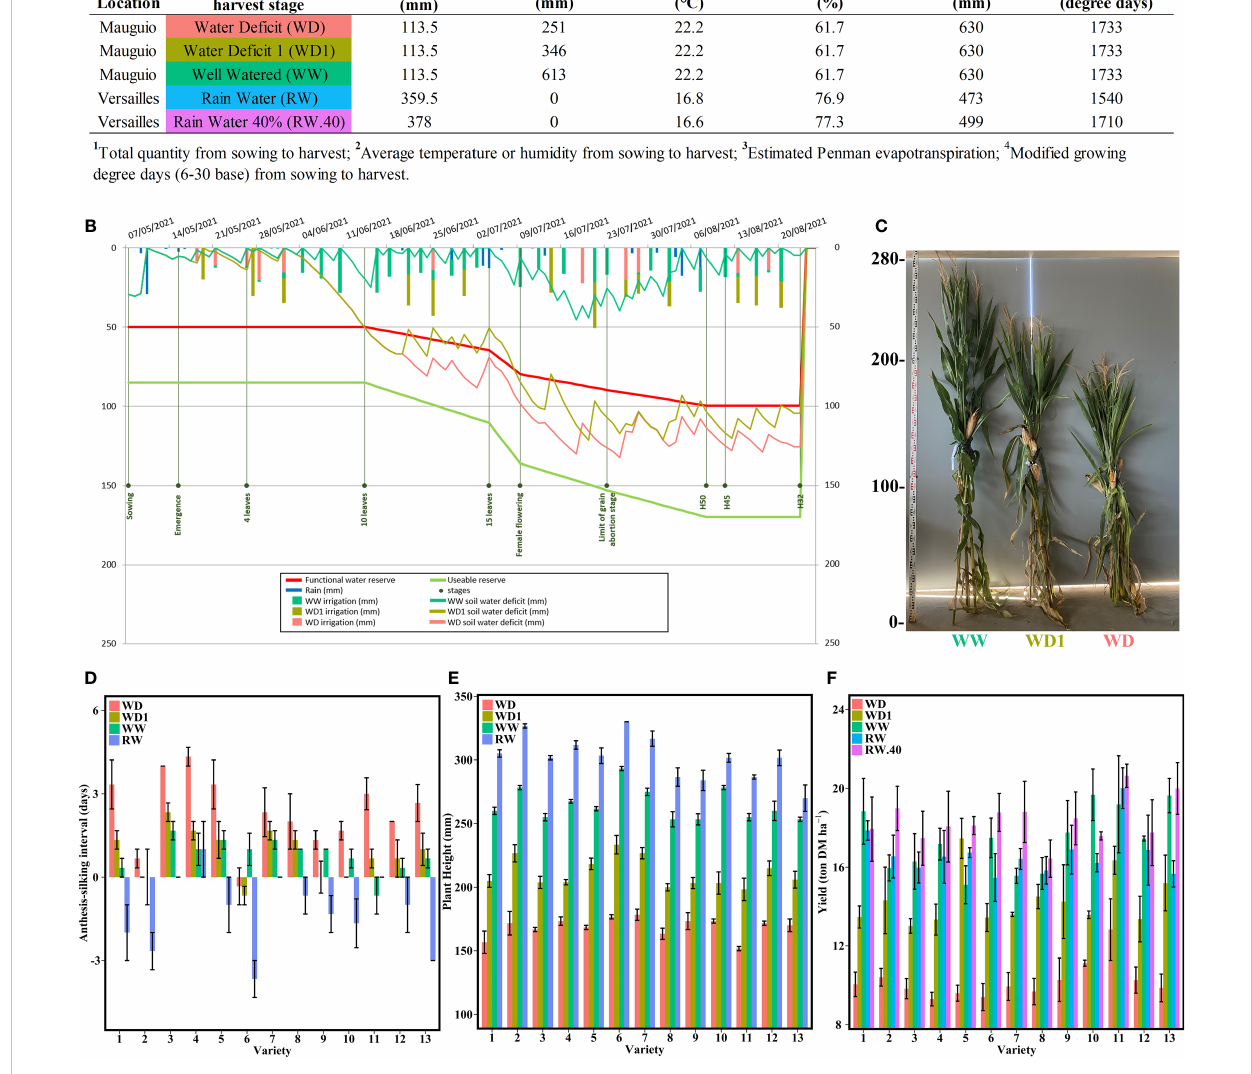
FIGURE 1 Harvest conditions and resulting effects on key agronomic parameters. (A) Main climatic and maintenance data related to the fi ve different conditions studied. (B) Water balance sheet generated by the Irre ́ lis irrigation advice software (Arvalis – Institut du vegetal) for the Mauguio fi eld trials. The data shown were measured on variety 8 in the WW condition. (C) Representative photo of the resulting plant heights for the variety 4 under the three conditions at Mauguio. (D) Anthesis-silking interval for each variety in Mauguio and Versailles. (E) Mean plant height in cm at harvest from the four conditions at Mauguio and Versailles. (F) Mean yield in tons of DM per ha for all varieties under the fi ve conditions in Mauguio and Versailles. The bars represent the means and the error bars indicate the standard error